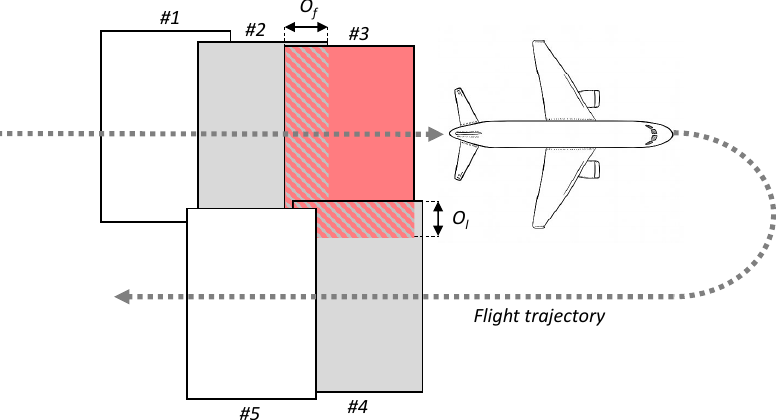
Figure 4. Forward and lateral overlap in aerial